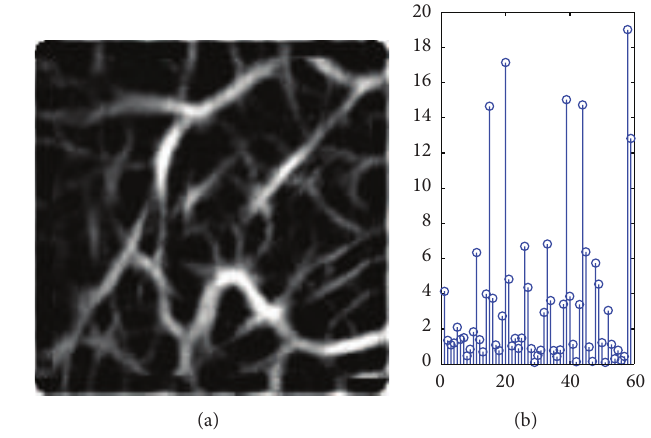
Figure 6: Palm vein image and LBPV